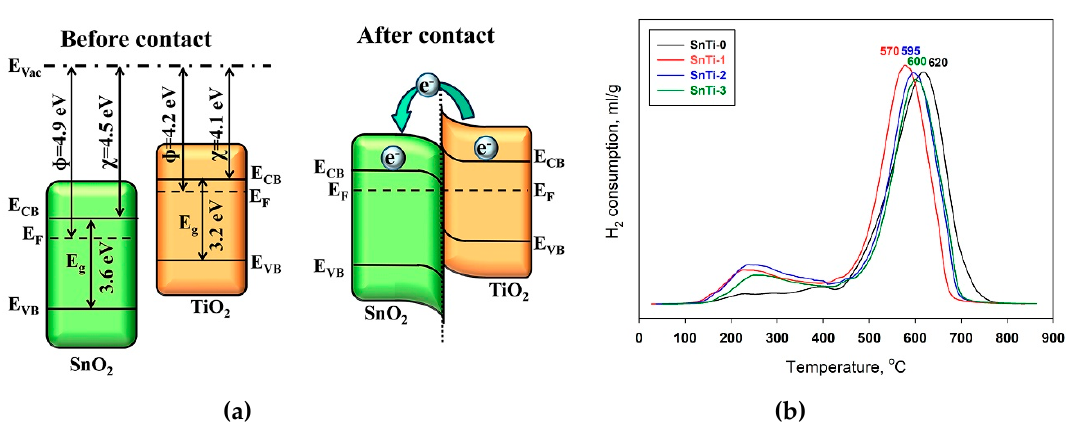
Table 4. Sensor characteristics of unmodified SnO 2 and TiO 2 @SnO 2 nanocomposites in HCHO detection at 150 °C.